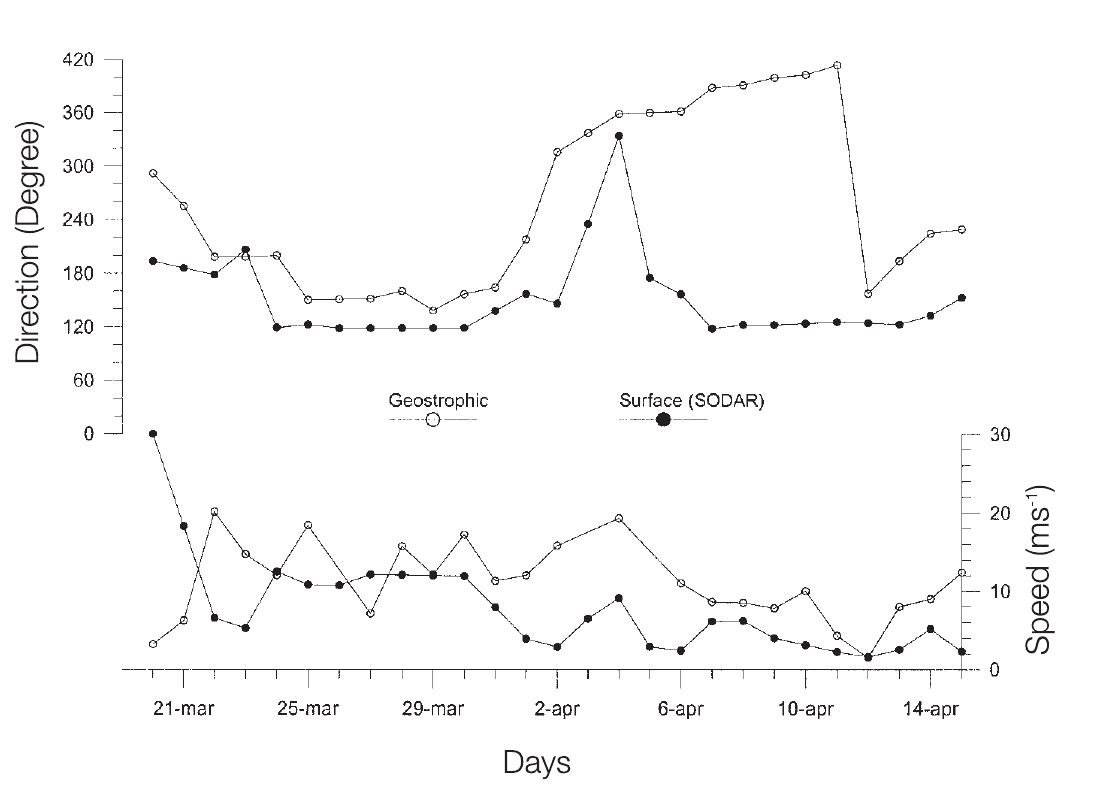
Fig. 3. Time series of the low level wind given by SODAR at 65 m, and the geostrophic wind by radiosounding during ARTIST at 1100